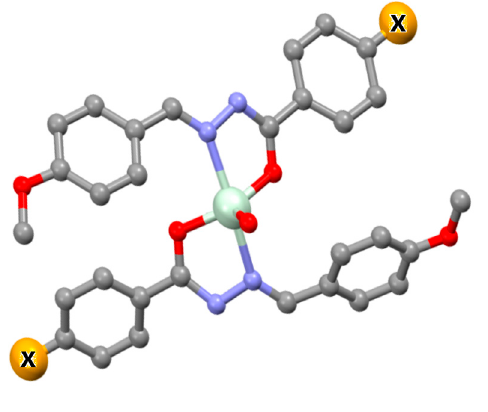
Figure 2. General picture of the crystal structure of Ac1 (X = F) and Ac2 (X = NO 2 ). The cation displays a trigonal bipyramidal geometry, including one water